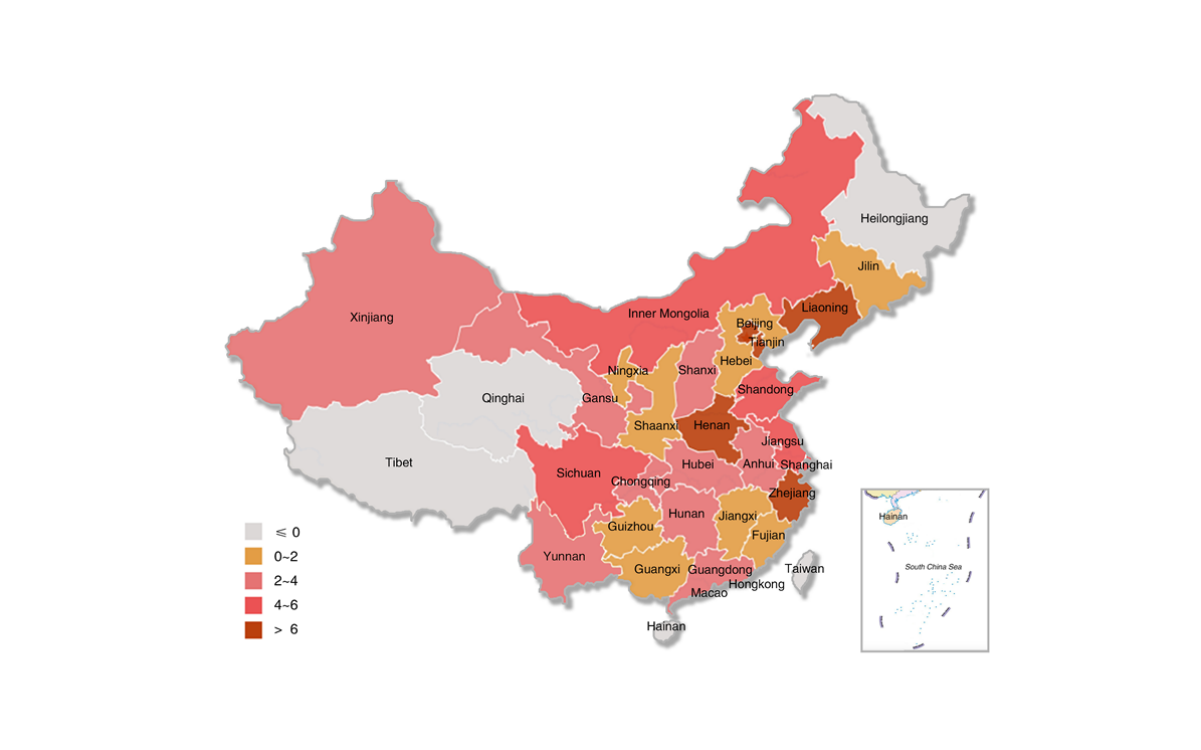
Figure 6. Diffusion of government Weibo accounts